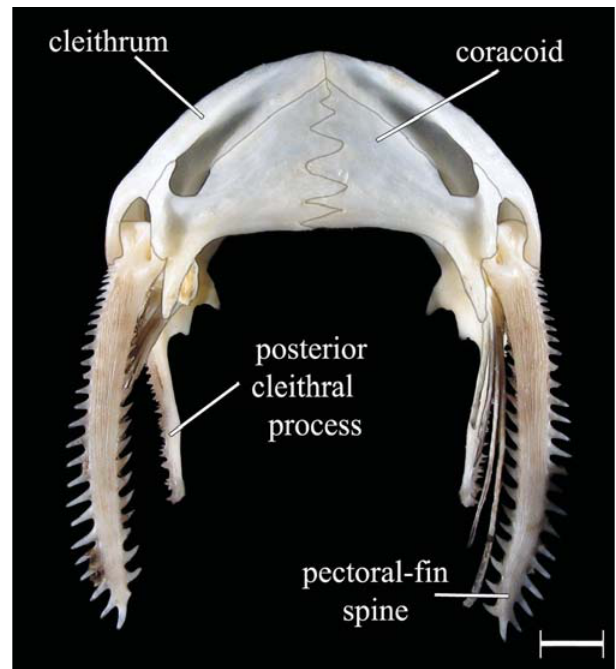
Fig. 6. Pectoral girdle in ventral view of Liosomadoras oncinus , MZUSP 105828, 99 mm SL. Scale bar = 5